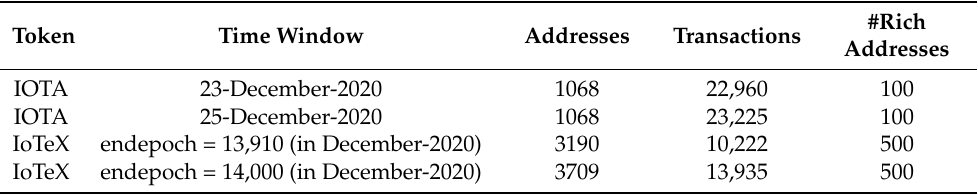
Table 8. Transaction data downloaded for IOTA and IoTeX complex network